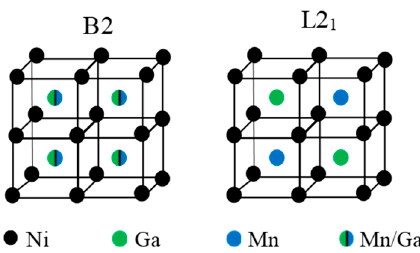
Figure 1. Atomic occupancies of the cubic lattice for B2 and L2 1 order in ternary Ni 2 MnGa alloy.